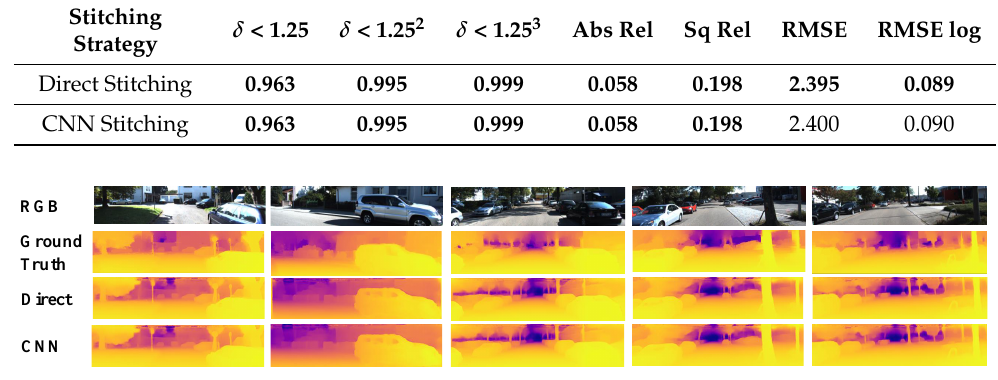
Figure 7. A visualization of the results from the different stitching strategies: direct stitching and CNN